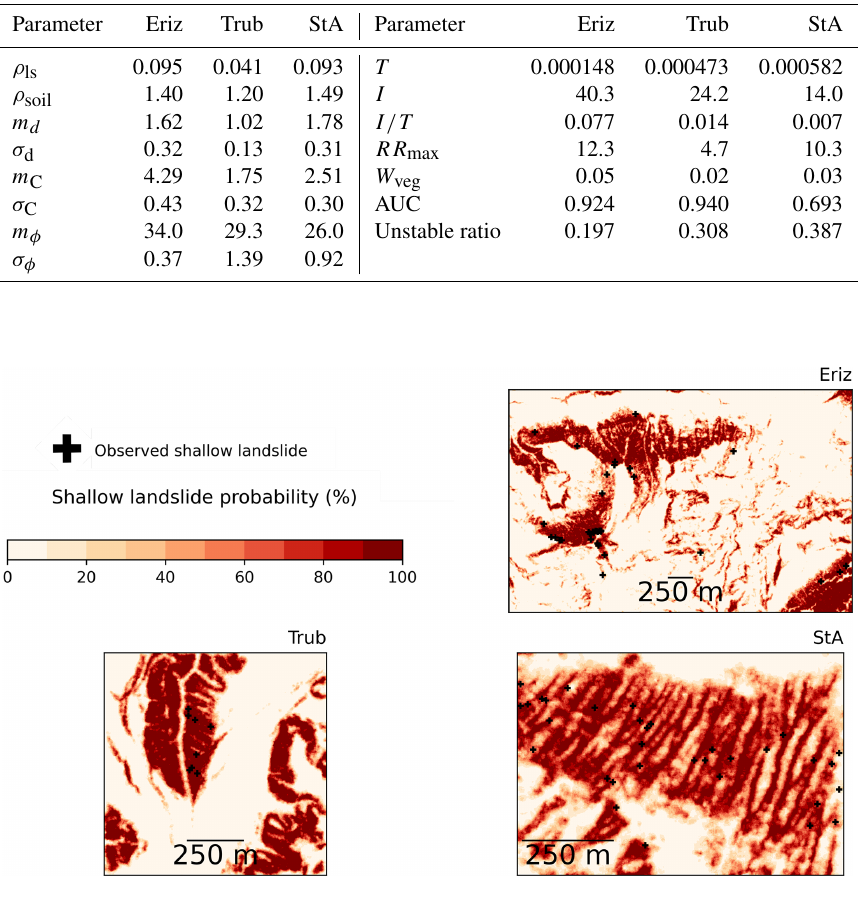
Figure 7. Overview of the landslide probability of the study areas simulated with the calibrated parameter sets of Table 7. Added as black crosses are the observed landslides from the